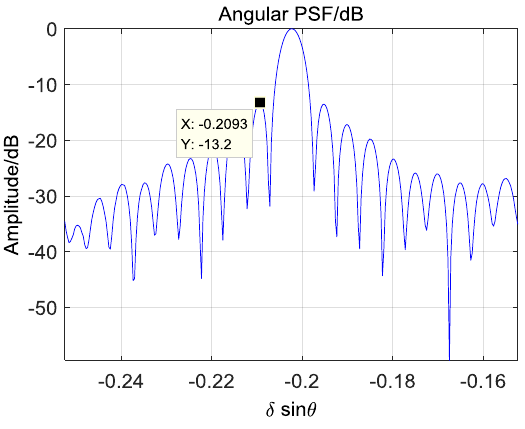
Figure 22. Imaging of corner reflector.